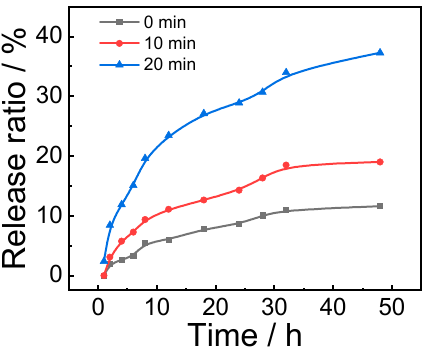
Figure 7. DOX releasing profile of PCOFA micelles under 410 nm light illumination (28 mW/cm 2 ) at different time intervals (0, 10 and 20 min).